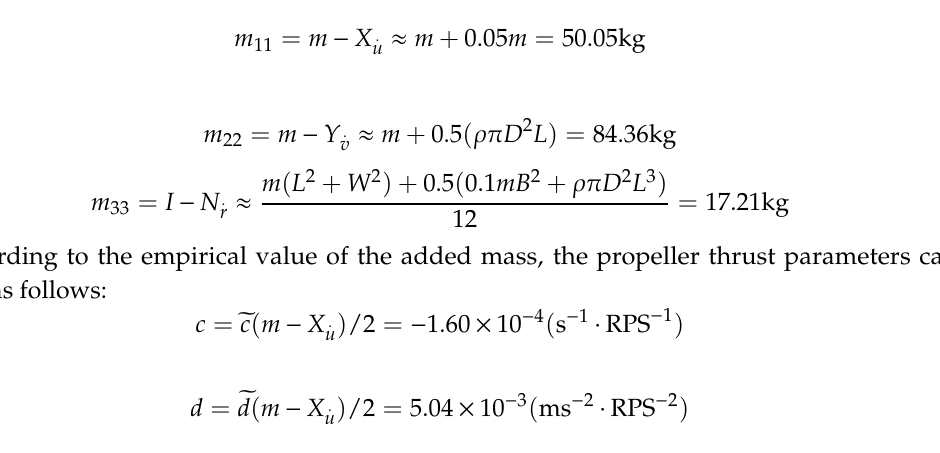
Figure 6. Relationship of initial acceleration, surge velocity, and propeller speed.